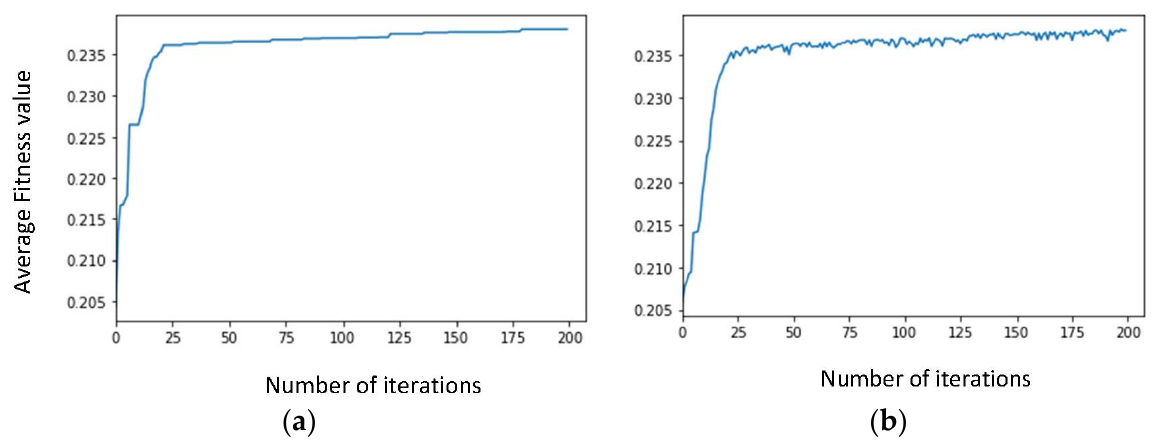
Figure 6 . Evolution of average fitness of ( a ) the best individual, ( b ) all the individuals, over the genetic loop, vs. number of iterations ‐ initial stop condition.